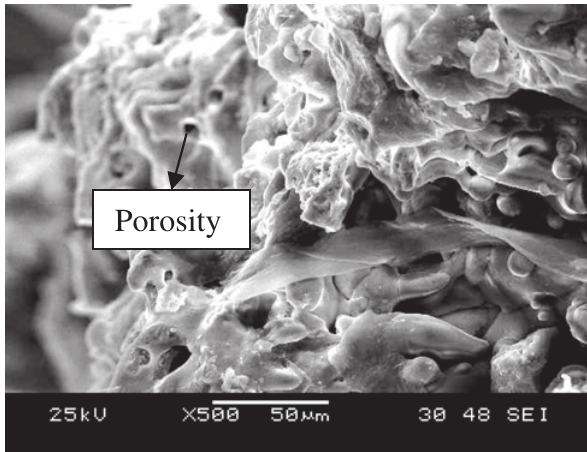
Figure 4: SEM micrograph of TGO at higher